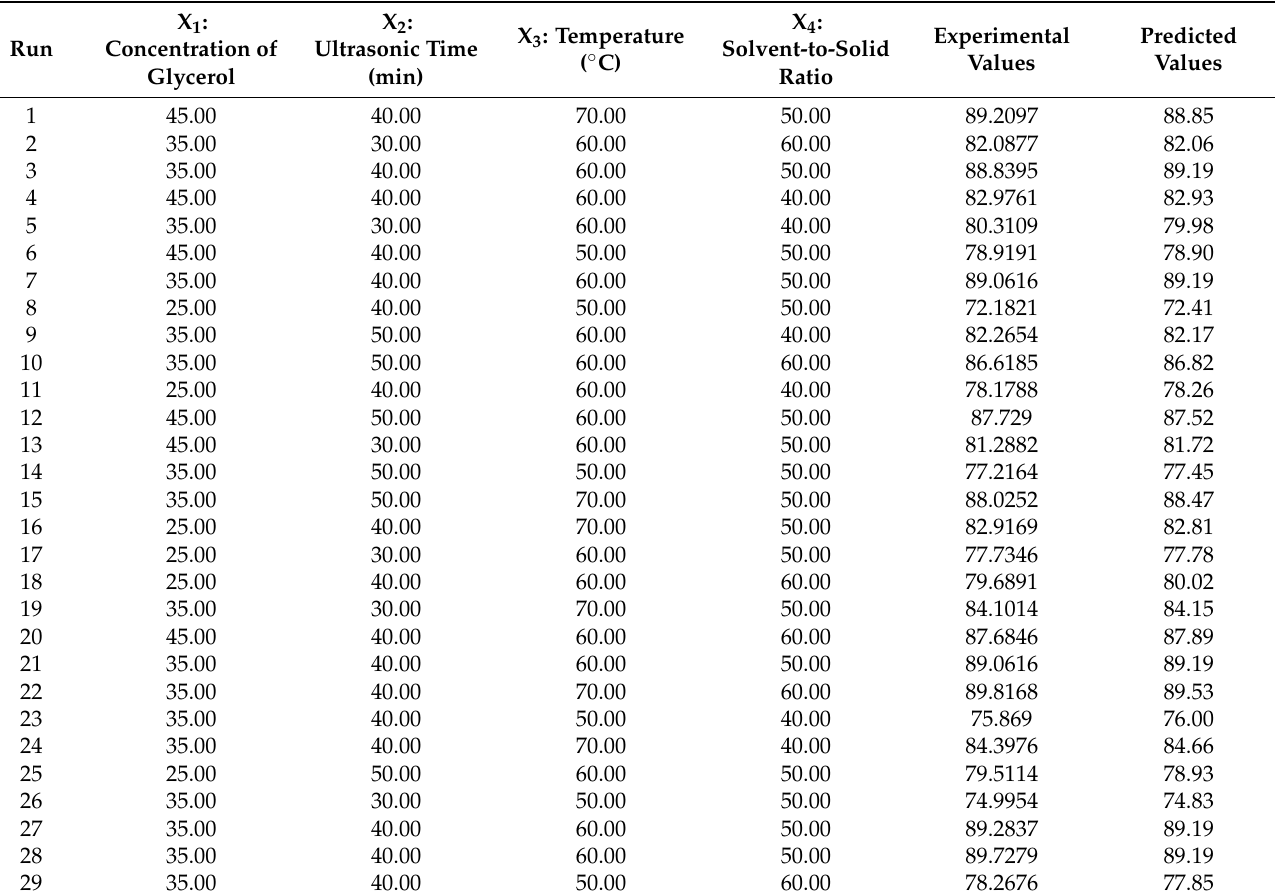
Table 2. The experimental and predicted values of 29 experiments obtained with BBD for